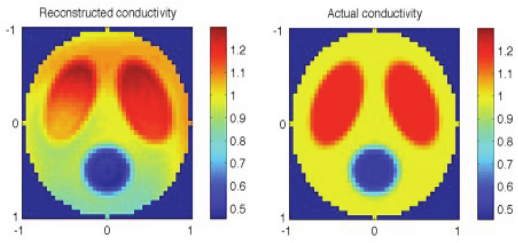
Fig. 10: Plots of the actual and reconstructed conductivities for the virtual phantom chest as re-arranged from